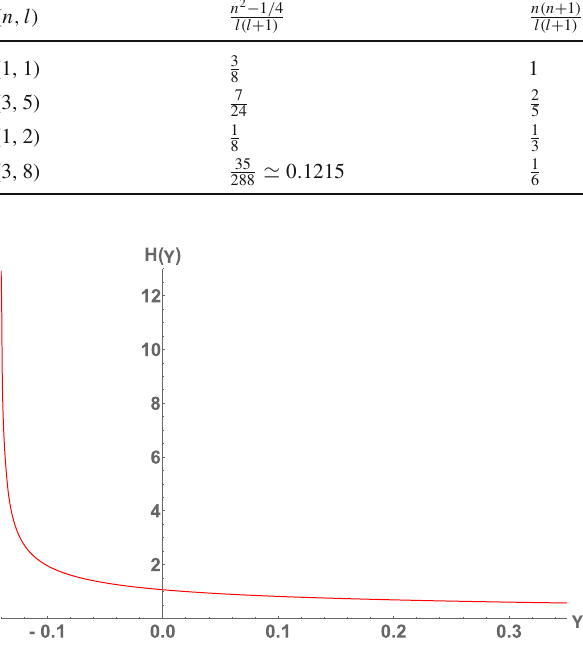
Fig. 6 An example of H calculated along near-extremal line r C ∼ r H . The calculation is performed with M = 1 and (cid:6) = 0 . 03